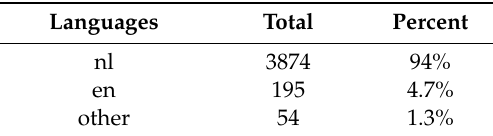
Table A29. Primary languages (it).